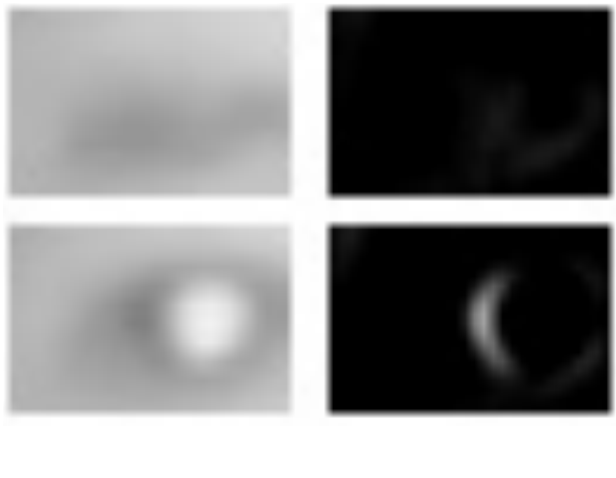
Figure 7. Eye image and filter image for both open and closed